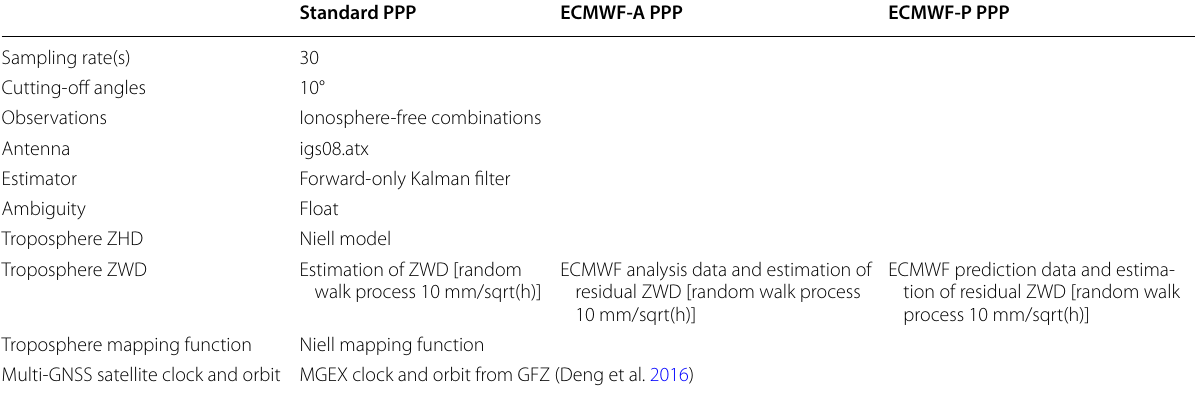
Table 1 PPP processing